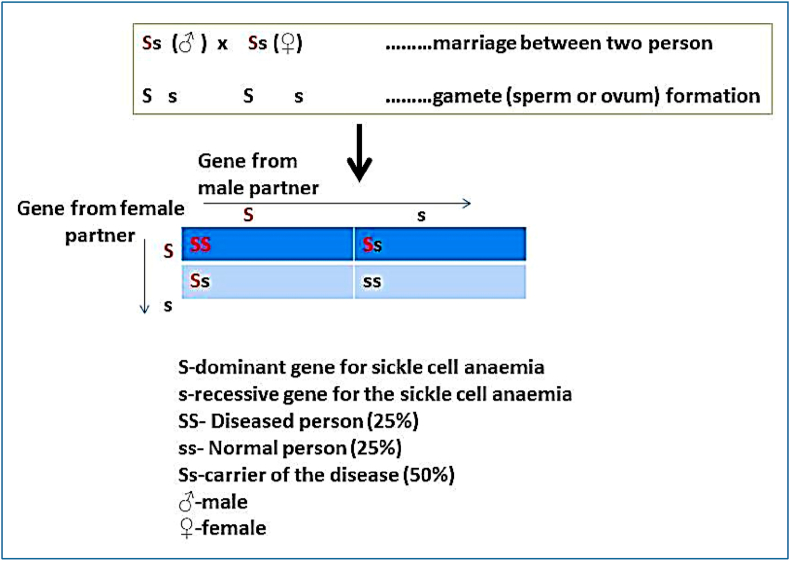
Social customs and scientific issues. Blood relation marriage and higher risk of transmission of genetic diseases, for example, sickle cell anaemia.